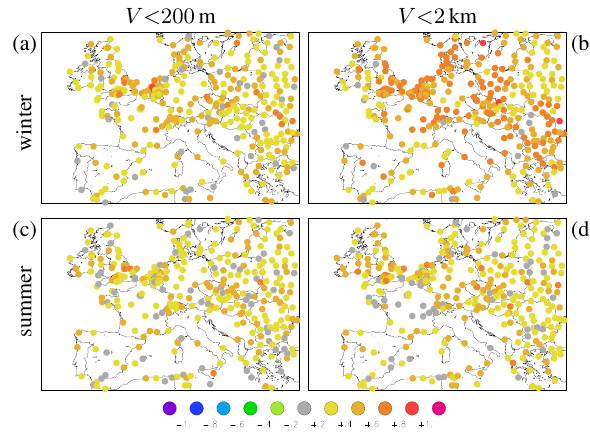
Fig. 16. Trends in January–March zonal geostrophic wind U [ms − 1 yr − 1 ] over 1948–2009 (a) and 1976–2006 (b) . In (a) only grid boxes with p< 0.1 are shown.